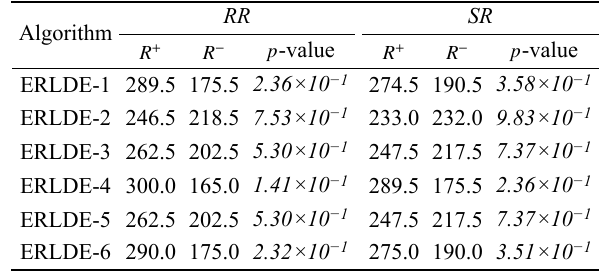
Table 6 Average rankings of different ERLDE variants obtained by the Friedman test in terms of RR and SR . and SR of different ERLDE variants.